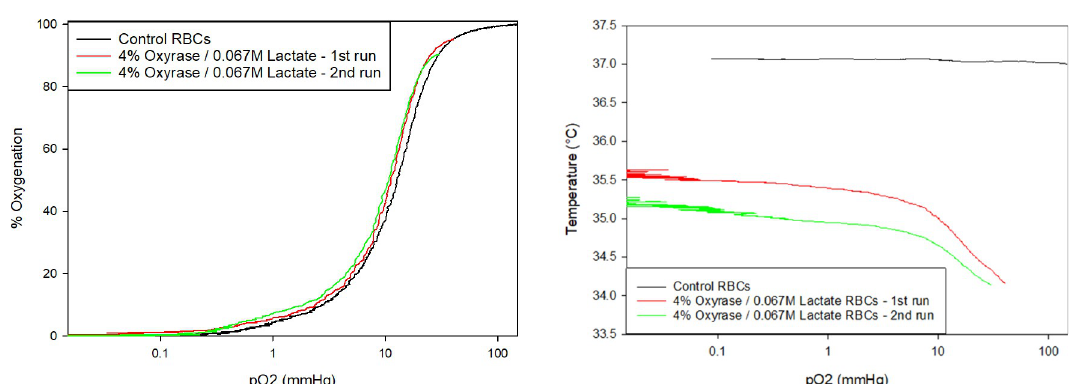
Fig 8. A. Oxygen equilibrium curves for healthy Hb. The control sample was produced by bubbling nitrogen gas through the sample, while the experimental sample was deoxygenated using Oxyrase. B. Temperature data for oxygen equilibrium curves. The left shift for the enzyme-treated Hb in Fig 8A is consistent with decreased temperature, due to the absence of temperature control during the enzymatic